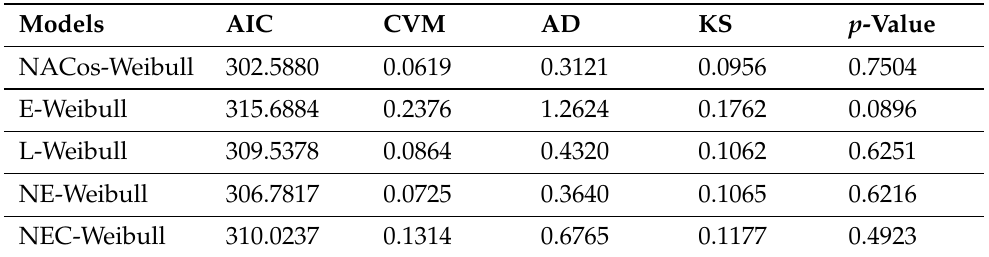
Table 9. For the failure times data set, the values of the selection criteria of the fitted